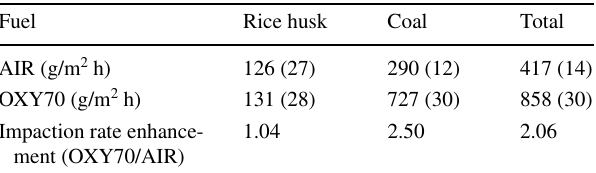
Table 5 Impaction rate prediction (% Impaction efficiencies η impaction are also reported within brackets)